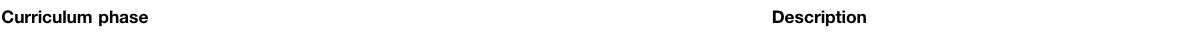
TABLE 1 | Roadmap and phase descriptions of the DIFFERENT